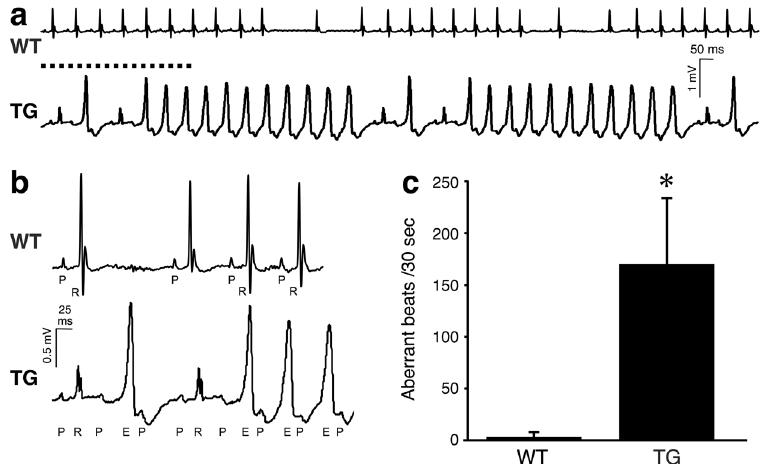
Figure 2. Atypical ECG patterns observed in the stress-ECG recordings. Surface ECG (lead-II) was recorded from anesthetized mouse over 40 weeks of age. ( a ) An administration of noradrenaline (1 mg/kg.BW i.p.) induced sinus tachycardia in WT and Kir6.1TG (line 673). WT strain occasionally showed missing regular contraction. Kir6.1TG strain frequently showed a series of aberrant conduction. The dotted line indicates the portion displayed in b. ( b ) Magnified ECG traces. WT maintains regular complex with P-wave (P) and a ventricular contraction (R). Kir6.1TG (line 673) maintains the regular rhythm of P-wave, while QRS complexes were frequently replaced with an ectopic form (E), suggesting ventricular conduction delay. The normal QRS complex of Kir6.1TG mouse also indicated fusion of the aberrant conduction with the normal conduction. ( c ) Highest occurrence of aberrant beats in a 30-sec period was analyzed between 10 and 20 minutes after noradrenaline injection. WT: n = 8, Kir6.1TG: n = 6. * p = 0.0082 (Kruskal-Wallis